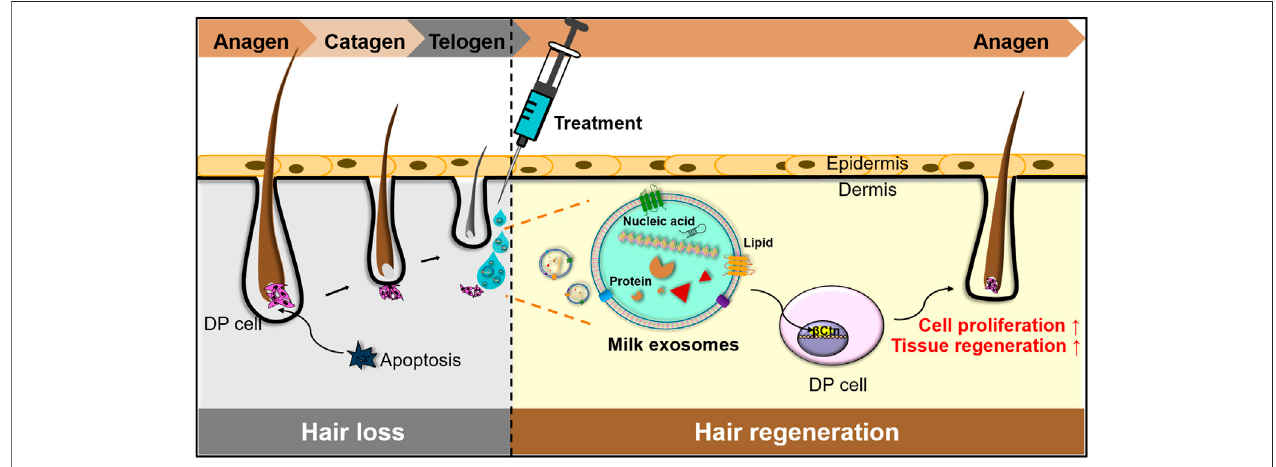
FIGURE 1 | Schematic illustration of Milk-exo-mediated phase transition from telogen to anagen for hair regeneration.